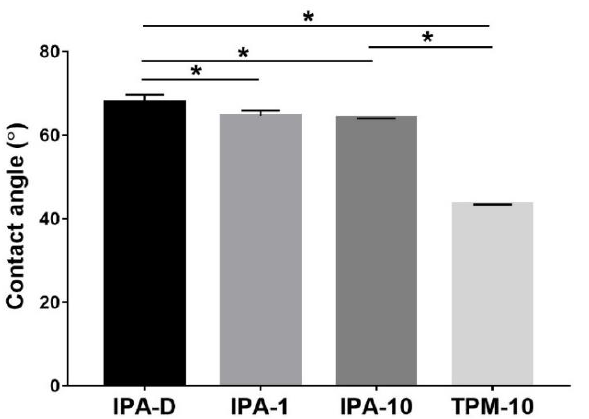
Figure 4. Contact angle for different washing conditions: * significant difference at p < 0.05.